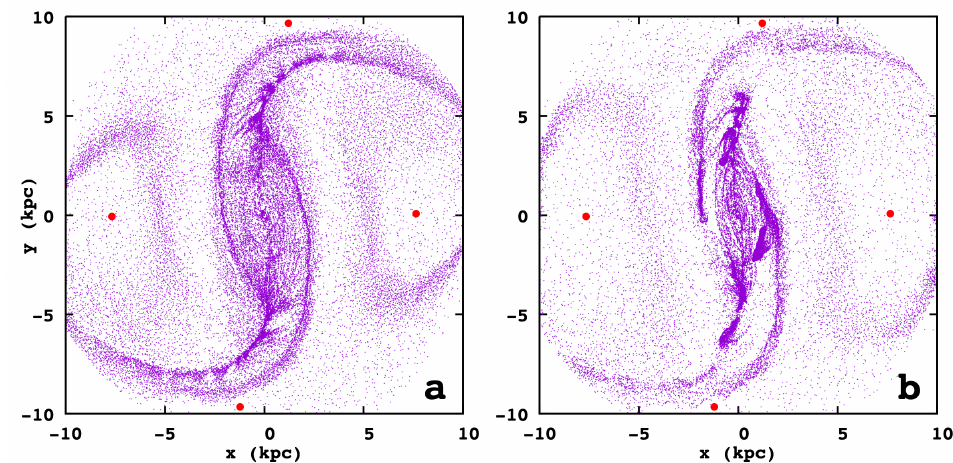
Figure 7. The SPH response without redistribution of the particles, during the growing phase of the bar, for t = 0.52 ( a ) and for t = 0.65 ( b ). The artificial viscosity parameters we used are ( α , β ) = ( 0.5,1 ) . In this, and in all relevant subsequent figures, the bar rotates counterclockwise. Red dots indicate the Lagrangian points of the